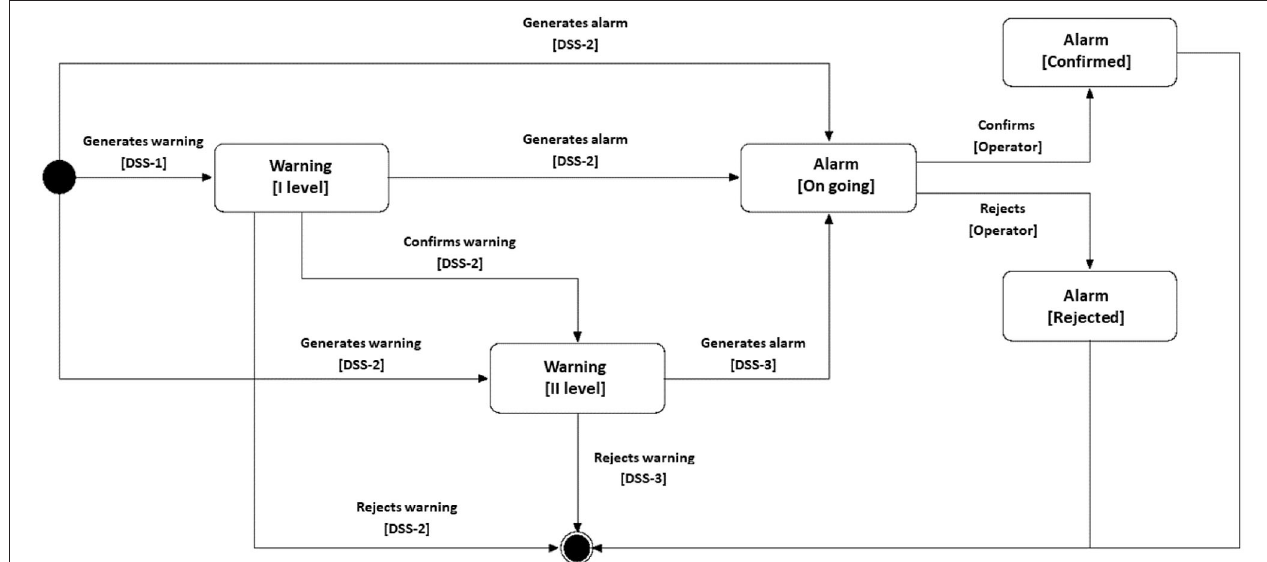
FIGURE 7 | A scheme that resumes all the possible interactions between the three levels of DSS.